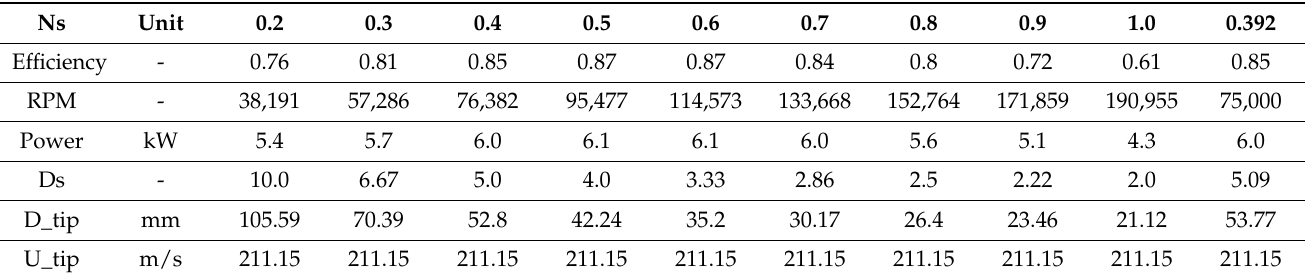
Table 3. Preliminary design results for Expander